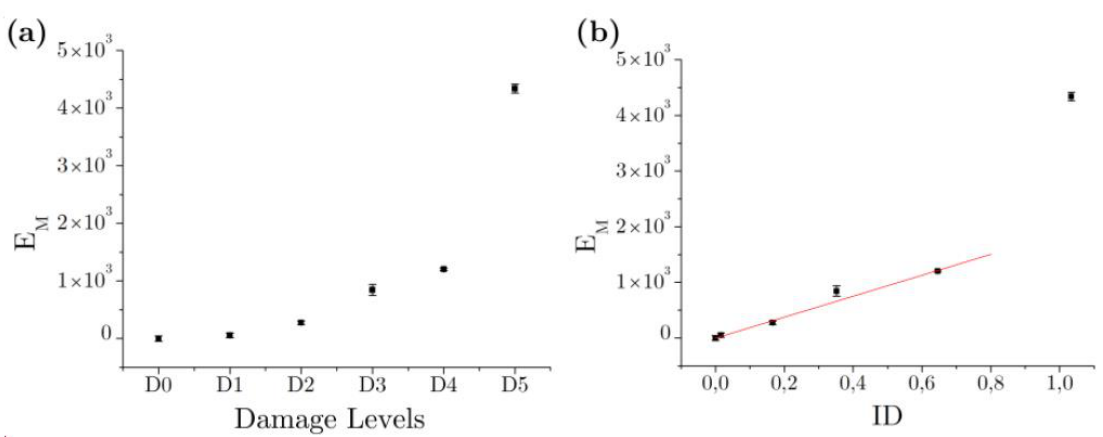
Figure 16. MMM inspection through trajectories H1 and H2. ( a ) Mean and standard deviation of the EM index for each D i . ( b ) Correlation E M